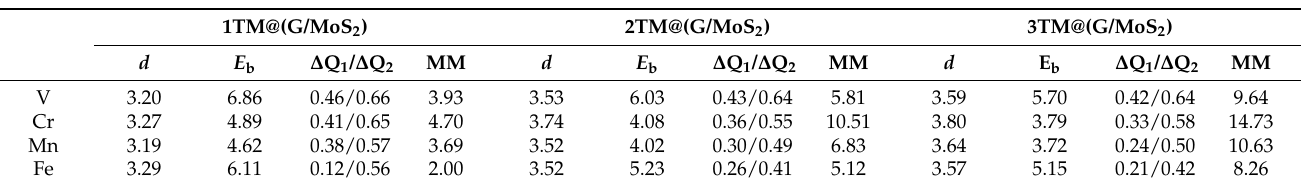
gain electrons. Detailed charges transferred to graphene and MoS 2 monolayers in all the studied 1TM@(G/MoS 2 ) heterostructures are summarized in Table 1; from TM = V to Fe, the charge transferred to the monolayer on both sides decreases gradually. Table 1. Distances between the graphene layer and MoS 2 layer ( d , Å), the binding energies (E b , eV), charges transferred from TM atoms to graphene ( ∆ Q 1 , e) and MoS 2 ( ∆ Q 2 , e), and magnetic moments (MM, µ B ).